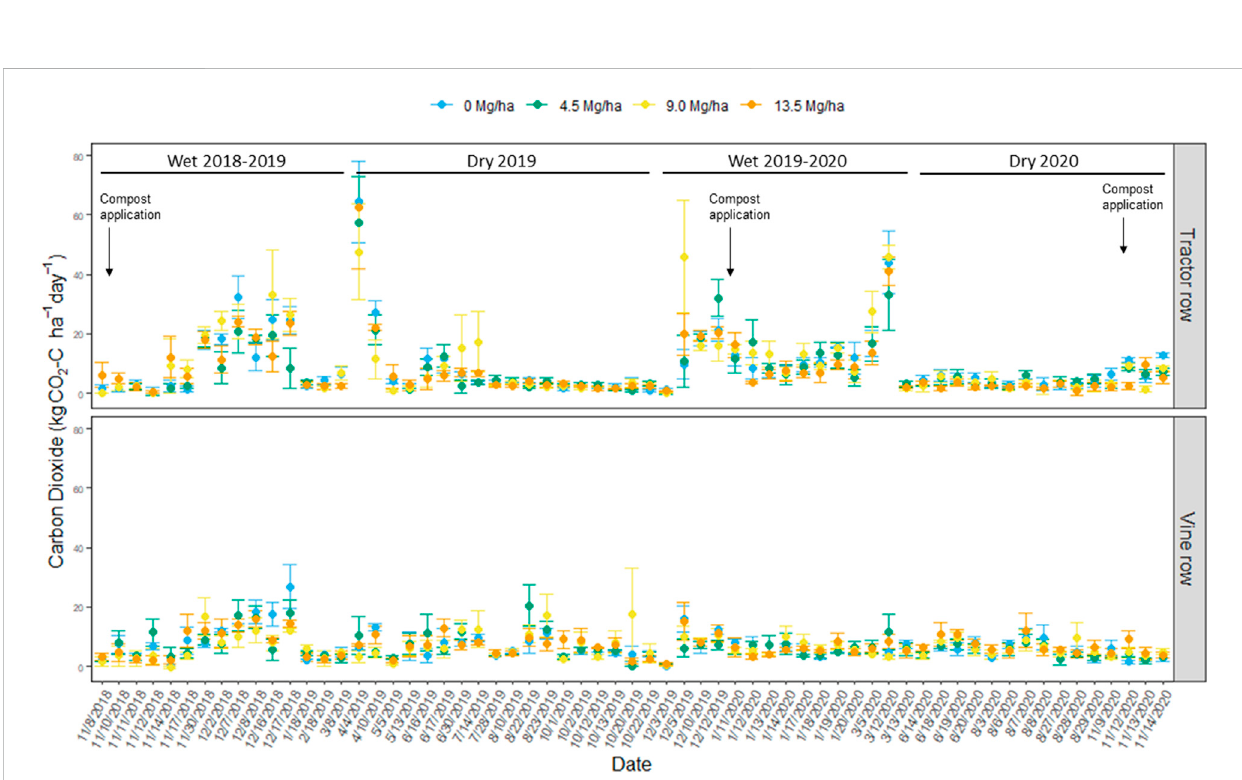
FIGURE 6 Average CO 2 daily fl uxes ± standard errors (n = 4) in the tractor row and under the vines at the four compost application rates during November 2018 — November